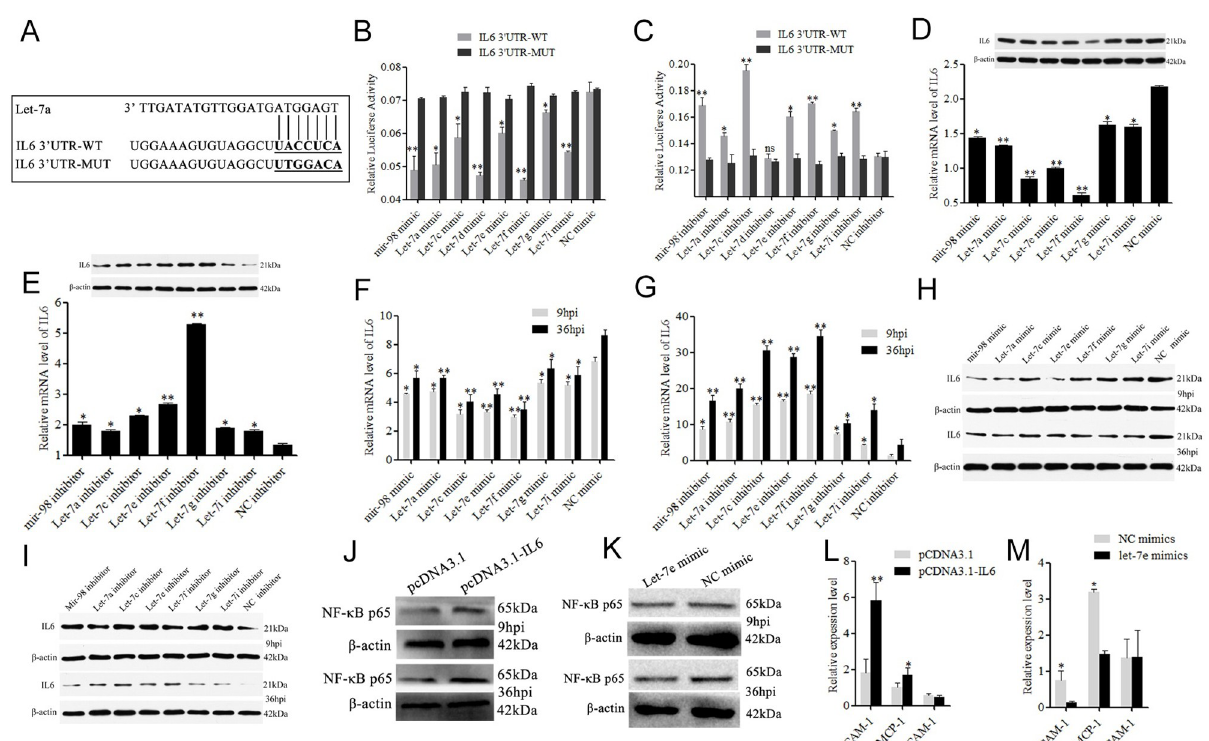
Fig 3. Let-7 family negatively regulate IL6 in Marc-145 cells. Bioinformatical predication showed that IL6 was a putative target gene of let-7 family (A). The dual luciferase reporter assay was performed in Marc-145 cells co-transfected with IL6 3’UTR-WT/IL6 3’UTR-MUT and let-7 mimics (B) or let-7 inhibitor (C). The expression of IL6 was analyzed in Marc-145 cells transfected with let-7 mimics (D) or inhibitor (E) by RT-qPCR and Western blot. Marc-145 cells were transfected with let-7 mimics/let-7 inhibitor, and then infected with PRRSV-2 for 9h or 36h, and the expressions of IL6 were detected by RT-qPCR (F, G) and Western blot (H, I). Marc-145 cells were transfected with pCDNA3.1-IL6 or let-7e mimics, and the expression of NF- κ B p65 protein (J, K) and VCAM-1 , MCP-1 , and ICAM-1 mRNA were detected (L, M). Data are expressed as the mean ± standard deviation of three independent experiments. P values were calculated using a Student’s t test. � p < 0 . 05 , �� p < 0 . 01